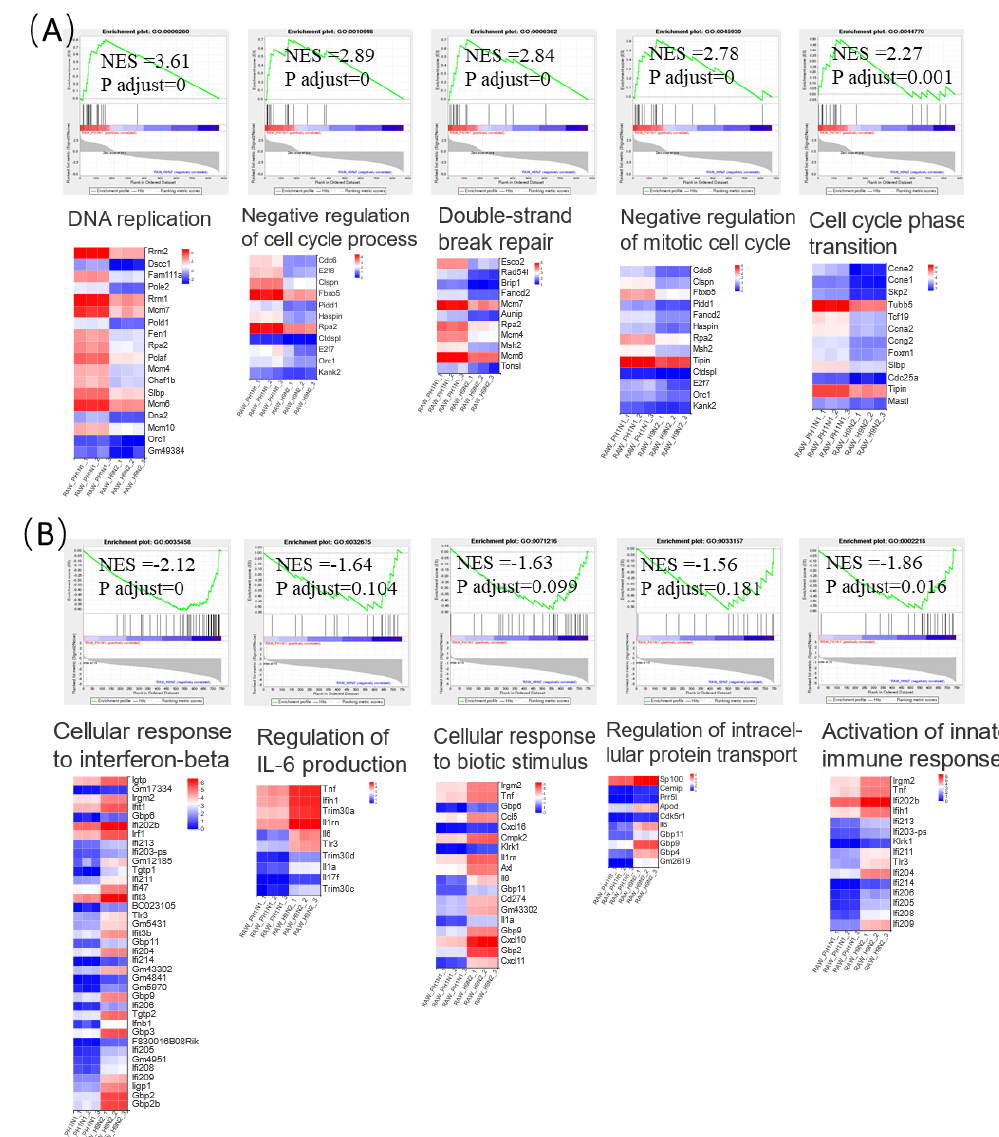
Figure 6. GSEA and expression heatmap. Ten representative significantly enriched gene sets from the GSEA of the RAW264.7 RNA-Seq data. ( A ) Enrichment plots comparing CA09 with PBS were depicted with five sets of genes; ( B ) enrichment plots comparing SD56 with PBS were depicted with five sets of genes, demonstrating the expression heatmap signatures of genes involved in the GSEA. Comparison of samples, NES, nominal p -value, and FDR q-value were determined using the GSEA software and are indicated within each enrichment plot.